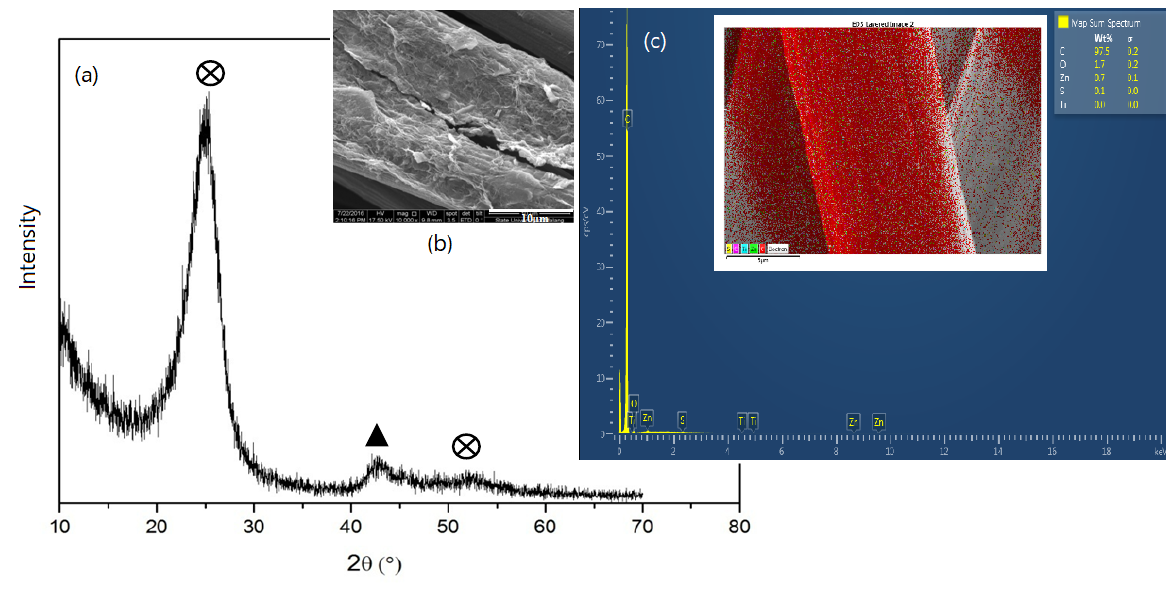
Figure 4: The XRD pattern (a) of ZnS/C along with its SEM image (b) and its elemental mapping and composition (c). Marker refers to ZnS peak and refers to carbon peak.